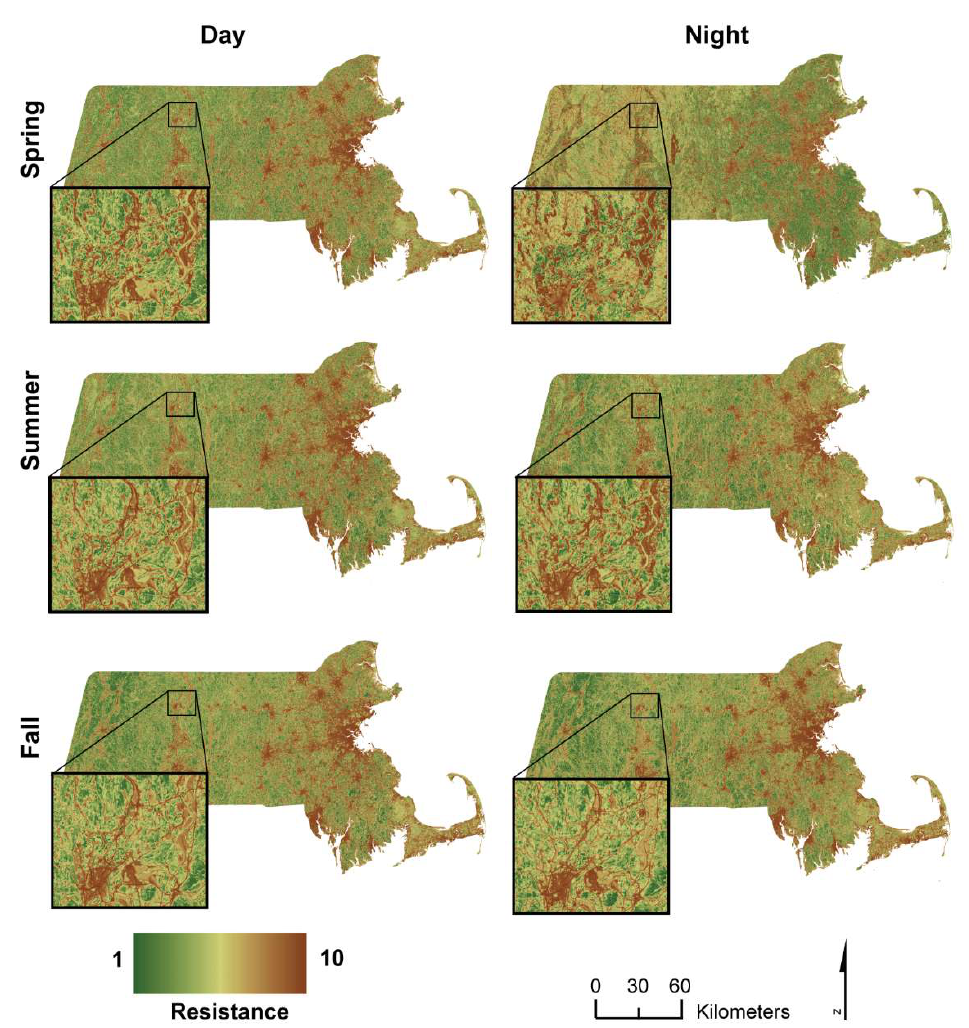
Figure A1. Resistance surfaces used in the individual based movement models. Insets provided to show detail. Figure adapted from Zeller et al.,